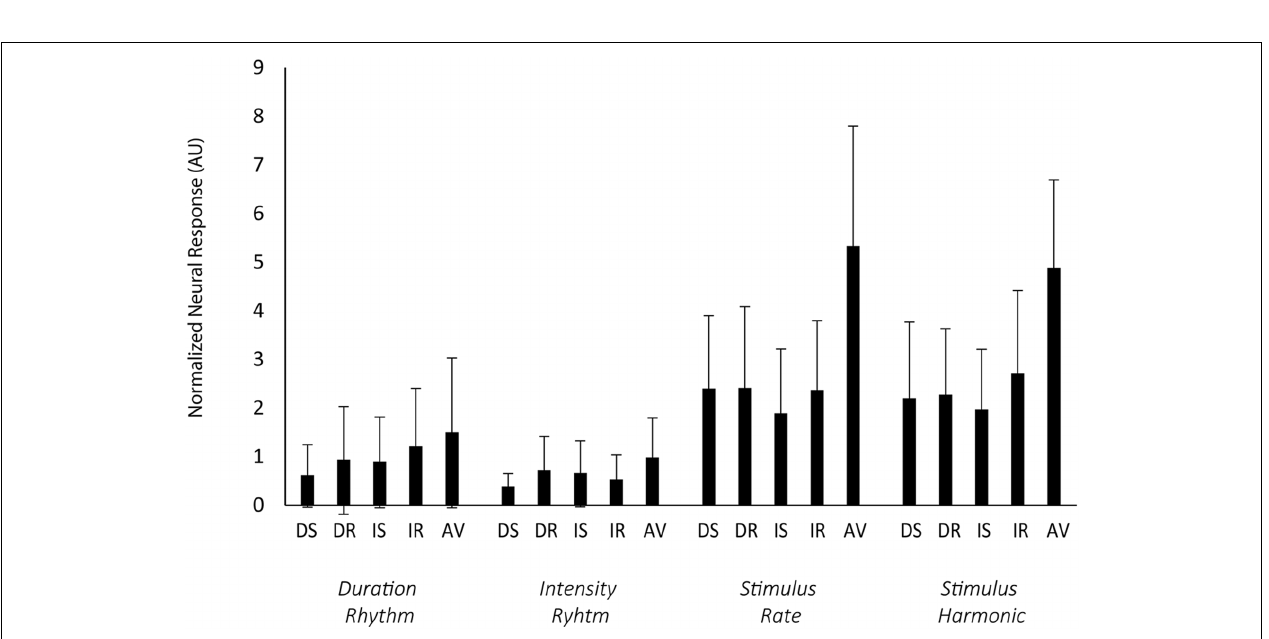
FIGURE 5 | Rhythmic entrainment. Rhythmic entrainment responses to the standard patterns are shown as the normalized neural response from the Cz electrode (y-axis), calculated as the square of the power of target frequency divided by the square of the average power in the surrounding 1 Hz frequency bin (excluding other target frequencies). Error bars display the standard deviation. Along the x-axis, the blue rectangles represent each task trial type (DS, duration switch trial; DR, duration repeat trial; IS, intensity switch trial; IR, intensity repeat trial; AV, attend visual stimuli). The sub x-axis is separated by duration rhythm (1.13 Hz), intensity rhythm (1.45), overall stimulus rate (4.45 Hz), and the first harmonic of the stimulus rate (9.10 Hz). The direction of attention had no effect on the strength of the responses. Attended rhythms in the Attend Auditory condition were not distinguished from unattended rhythms in the Attend Auditory condition.